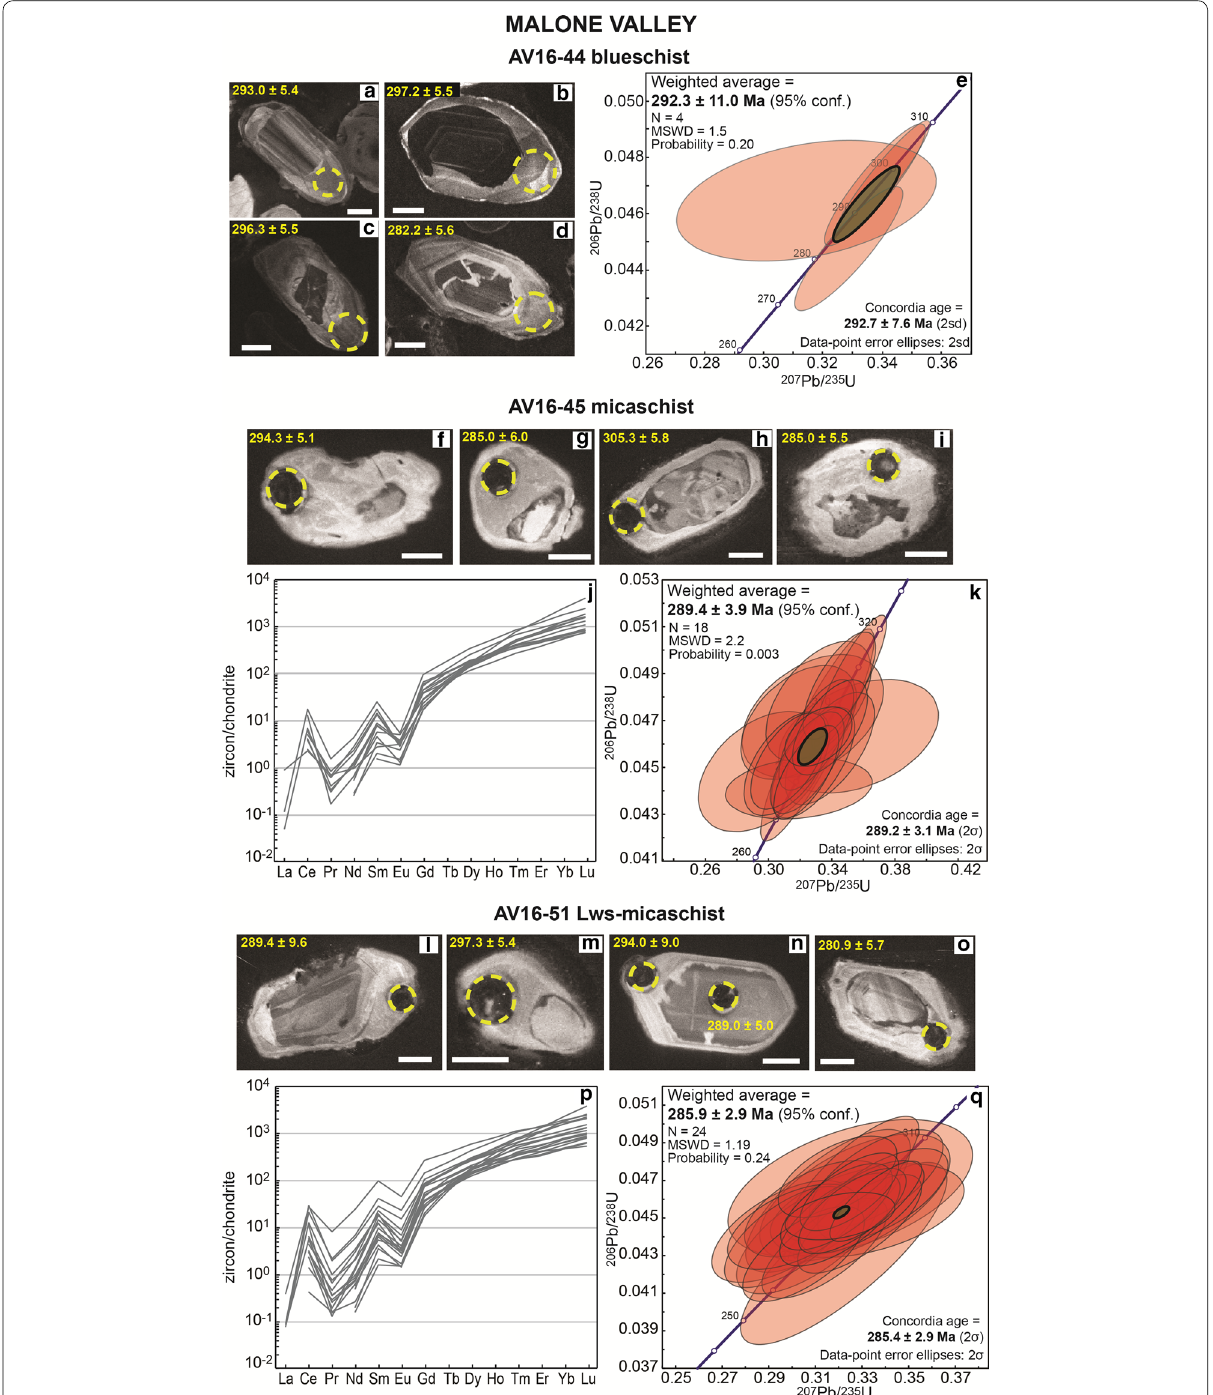
Fig. 3 Zircon in metasediments from Malone Valley. Blueschist AV16-44: a – d CC images of the analysed zircon grains. Scale bar in all images is 30 μm. Measured spots are shown (yellow circles) with the associated date ( 1σ Ma). e Concordia plot of zircon rim dates and weighted average 206 Pb/ 238 U age. ± The green circle represents the calculated Concordia age. Micaschist AV16-45: f – i Selected CC images of analysed zircon grains. Scale bar in all images is 30 μm. Measured spots are shown (yellow circles) with the associated date ( 1σ Ma). j REE patterns of zircon rims. k Concordia plot of zircon rim dates ± and weighted average 206 Pb/ 238 U age. The green circle represents the calculated Concordia age. Lws-micaschist AV16-51: l – o Selected CC images of analysed zircon grains. Scale bar in all images is 30 μm. Measured spots are shown (yellow circles) with the associated date ( 1σ, Ma). p REE patterns of ± zircon rims. q Concordia plot of zircon rim dates and weighted average 206 Pb/ 238 U age. The green circle represents the calculated Concordia